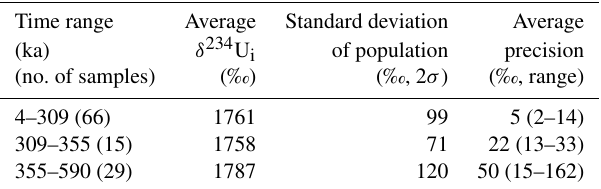
Table 1. Statistics of δ 234 U i with different temporal